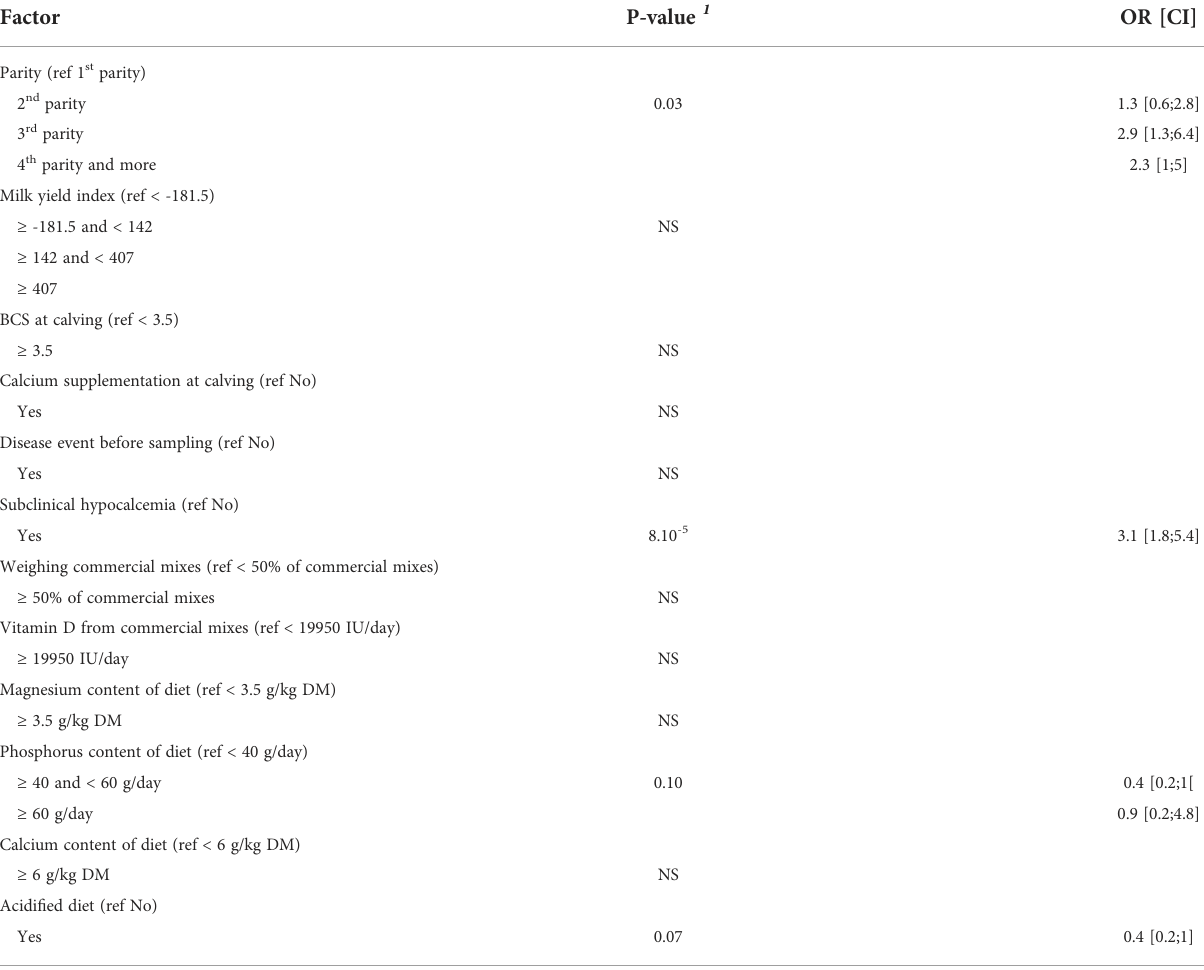
TABLE 7 Results from multivariate model quantifying the effects of parity, milk yield index and feeding practices during dry off on occurrence of subclinical hypophosphatemia (SHP), P-values, odds ratios (OR) and associated con fi dence intervals (CI) (n = 371 cows).